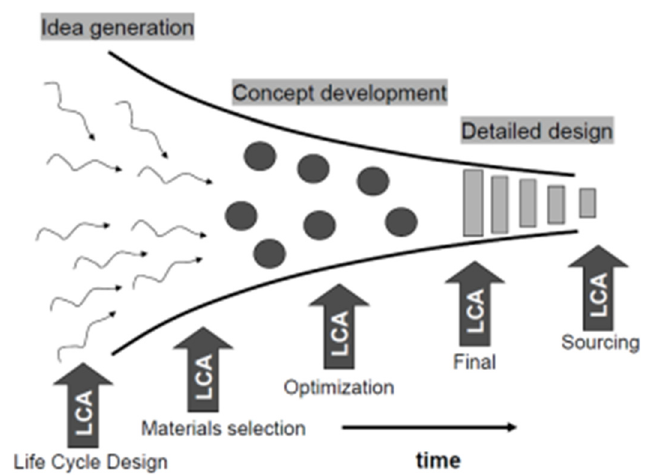
Figure 8. The use of LCA during all product development stages